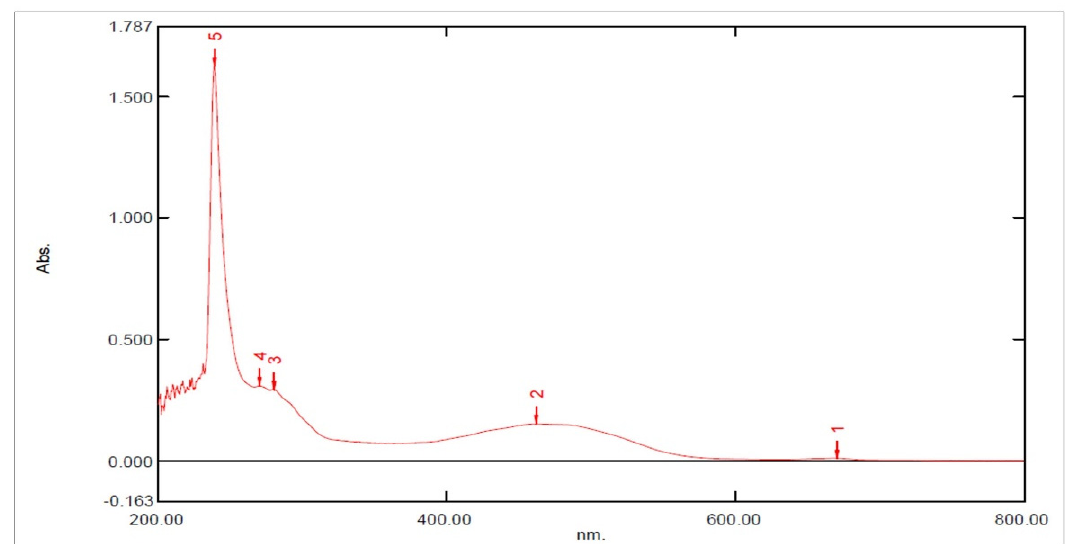
Figure 5. Absorption (UV) spectrum of the purified compound from the extracts of Leucas indica flowers. The peaks observed in UV spectra from 1 to 5 represent different electronic excitations of organic